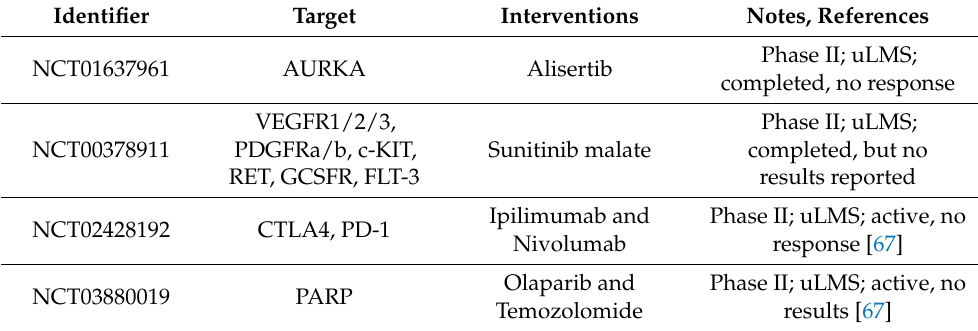
Table 1. List of clinical trials including uLMS